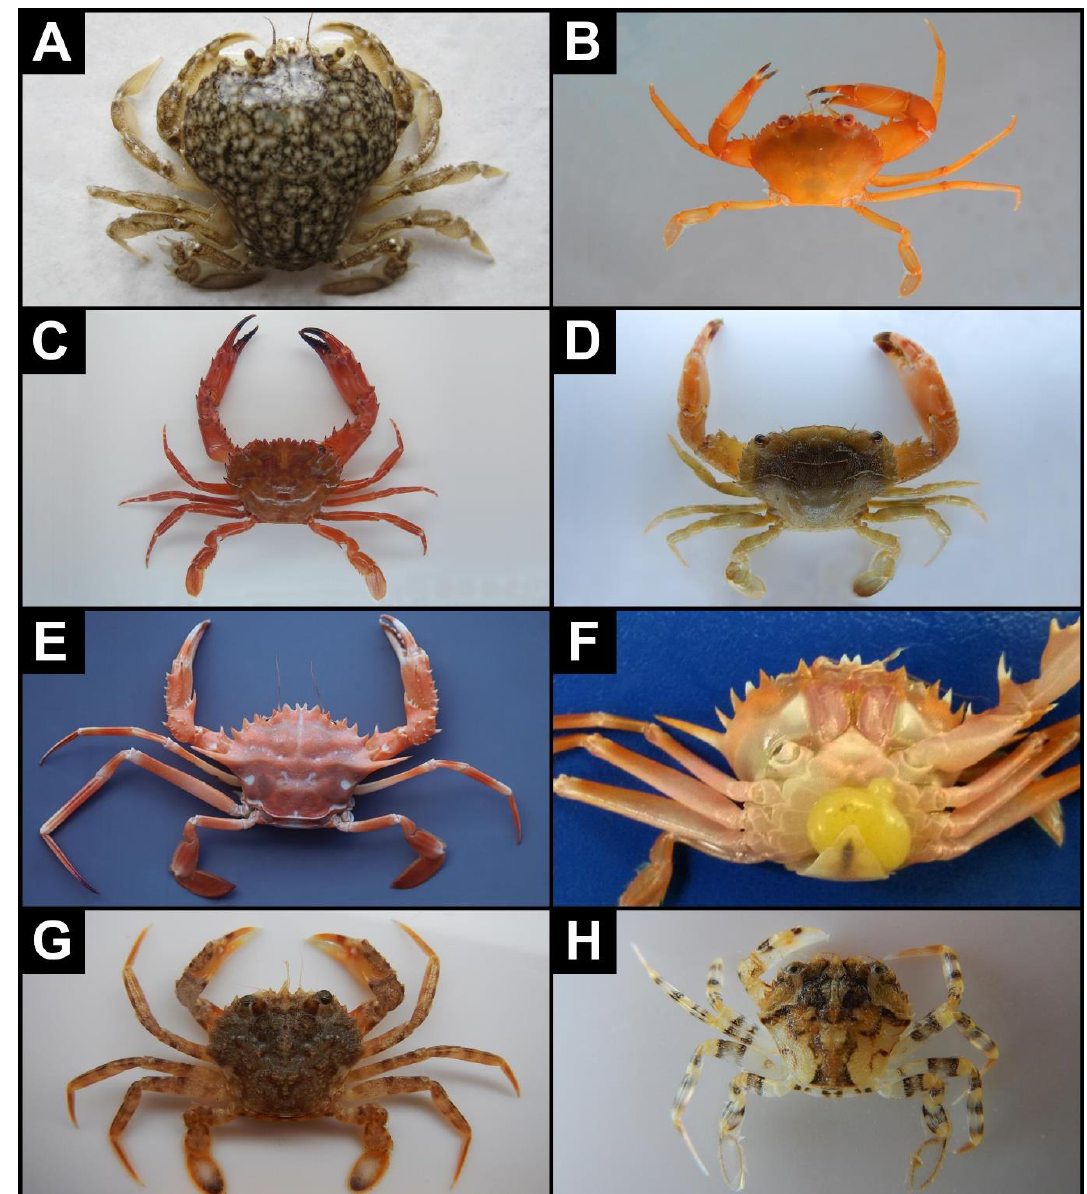
Figure 3. Decapods from Rhodes area, in colours. ( A ) Portumnus latipes , CL 27.2 mm; ( B ) Carupa tenuipes , CL 15.2 mm; ( C ) Gonioinfradens giardi , CL 36.9 mm; ( D ) Thalamita poissonii , CL 21.4 mm. ( E ) Bathynectes maravigna , CL 42.2 mm; ( F ) Bathynectes maravigna , CL 19 mm, parasitized by Sacculina sp.; ( G ) Liocarcinus bolivari , CL 20.6 mm; ( H ) Liocarcinus bolivari , CL 8.6 mm, juvenile.